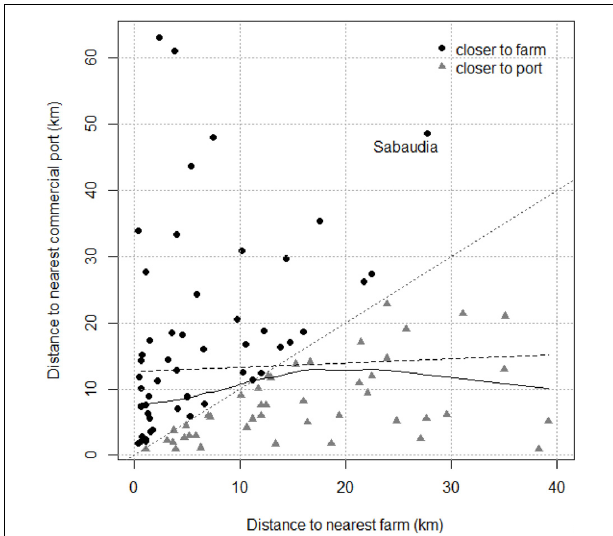
FIGURE 3 | Dispersion diagram for Abnormally Tough Specimen (ATS) observations. The dashed and full black lines are linear and smooth relationships between distance to the nearest farm and distance to the nearest commercial port, respectively. Black dots above the dotted 0–1 gray line are ATS observations closer to farms, gray triangles under are closer to commercial ports. Sabaudia ATS observation is highlighted.